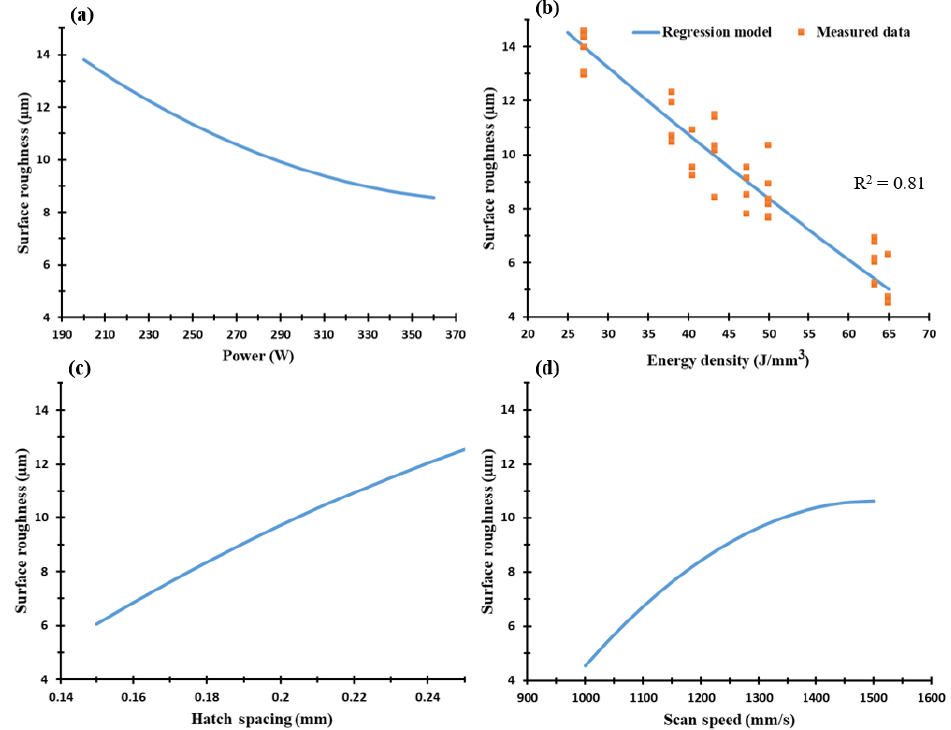
Figure 10. Surface roughness of the as-built AlSi10Mg samples vs. ( a ) laser power (W), ( b ) energy density (J/mm 3 ), ( c ) hatch spacing (mm), and ( d ) scan speed